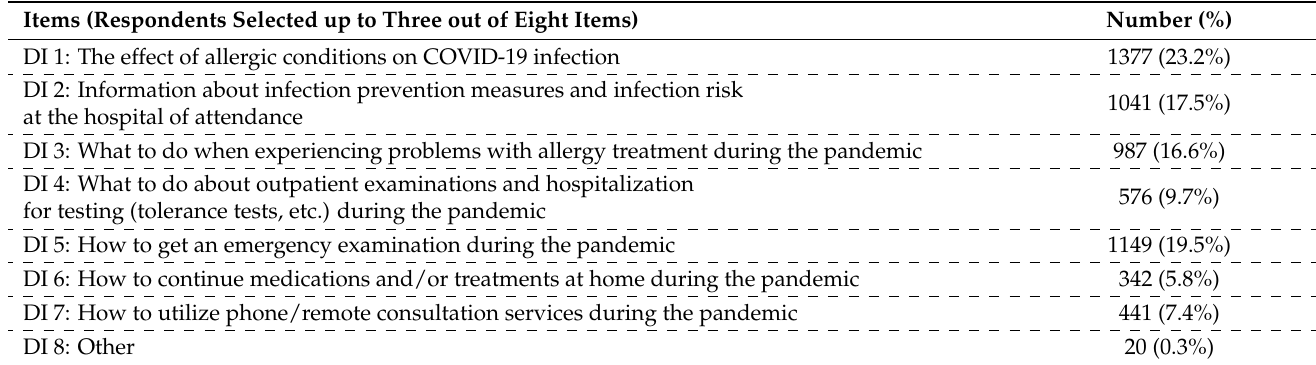
Table 4. Prevalence of fears among 2302 parents 1